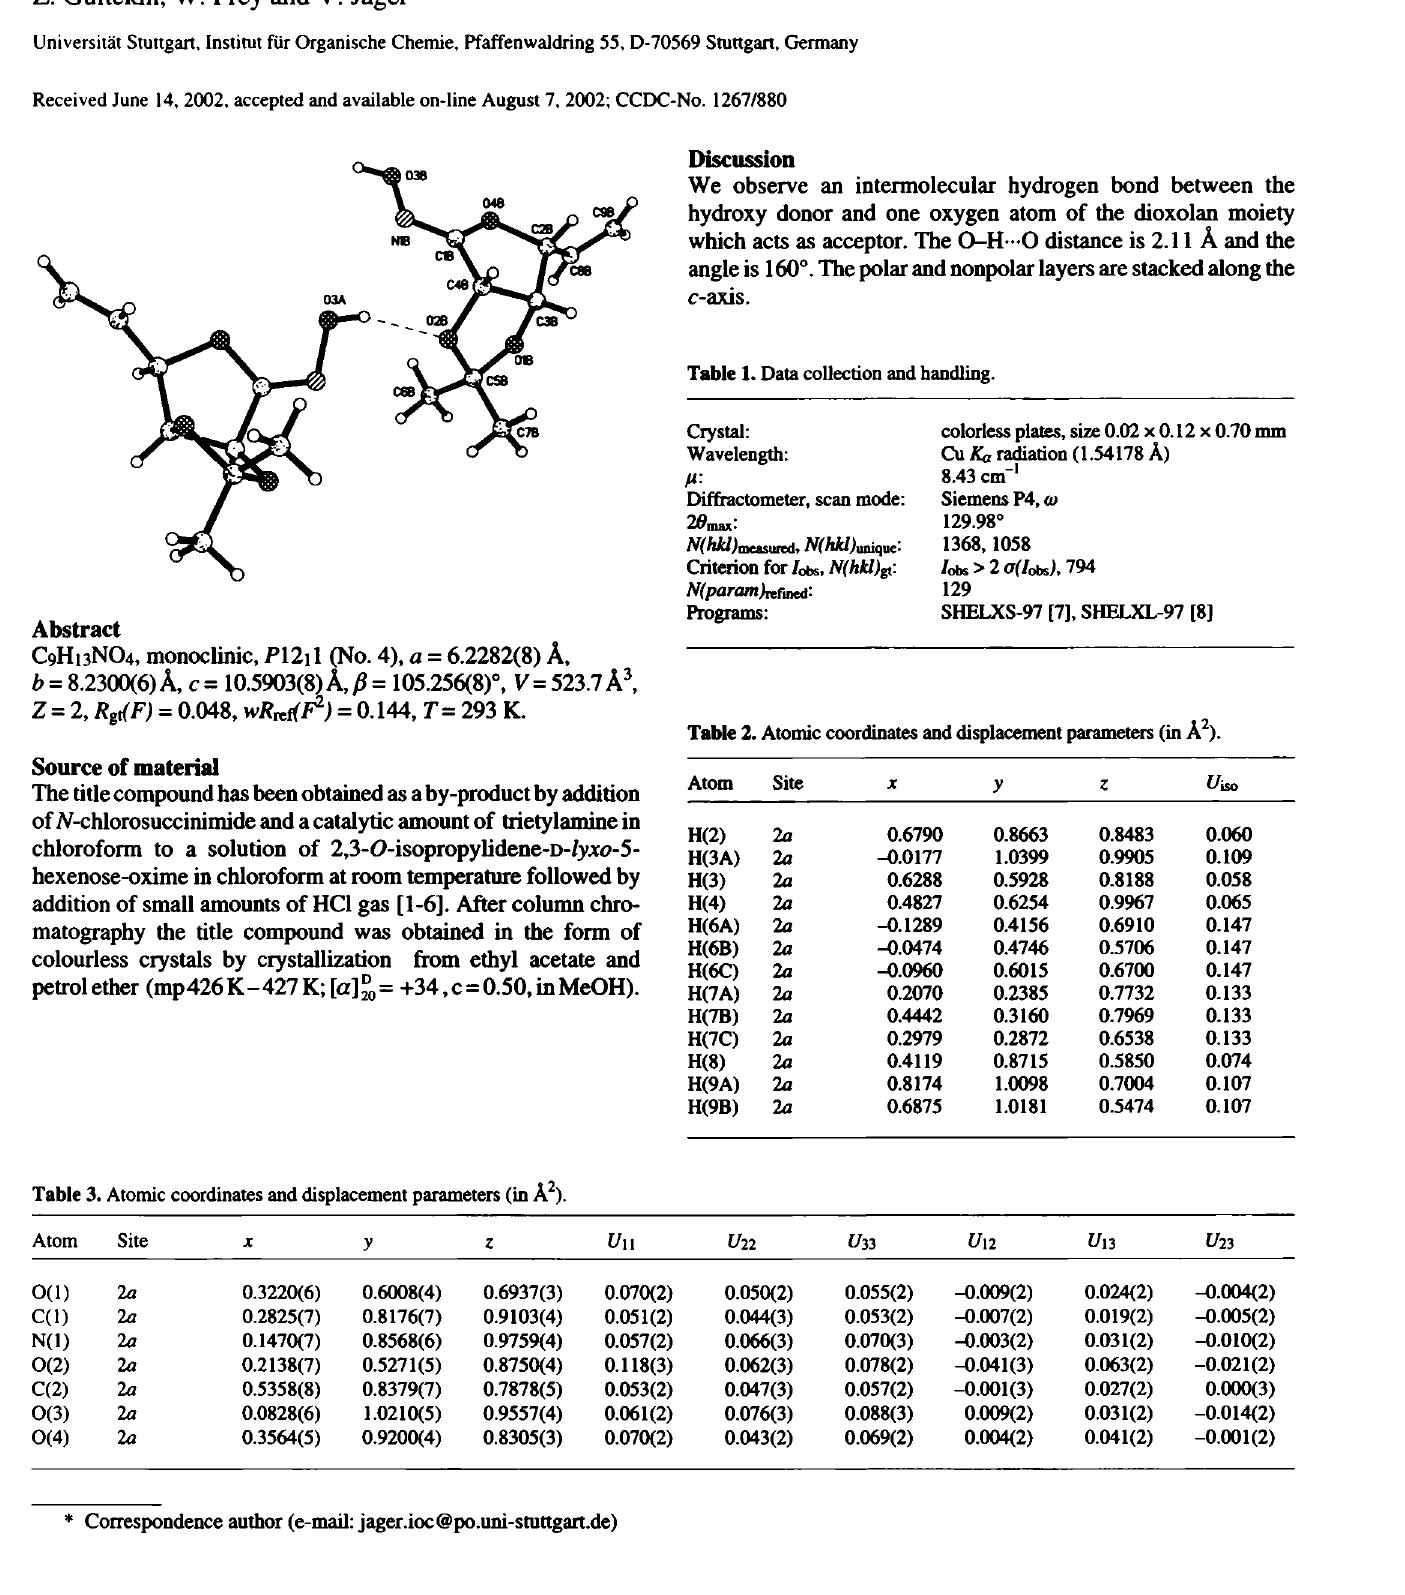
Table 1. Data collection and handling.